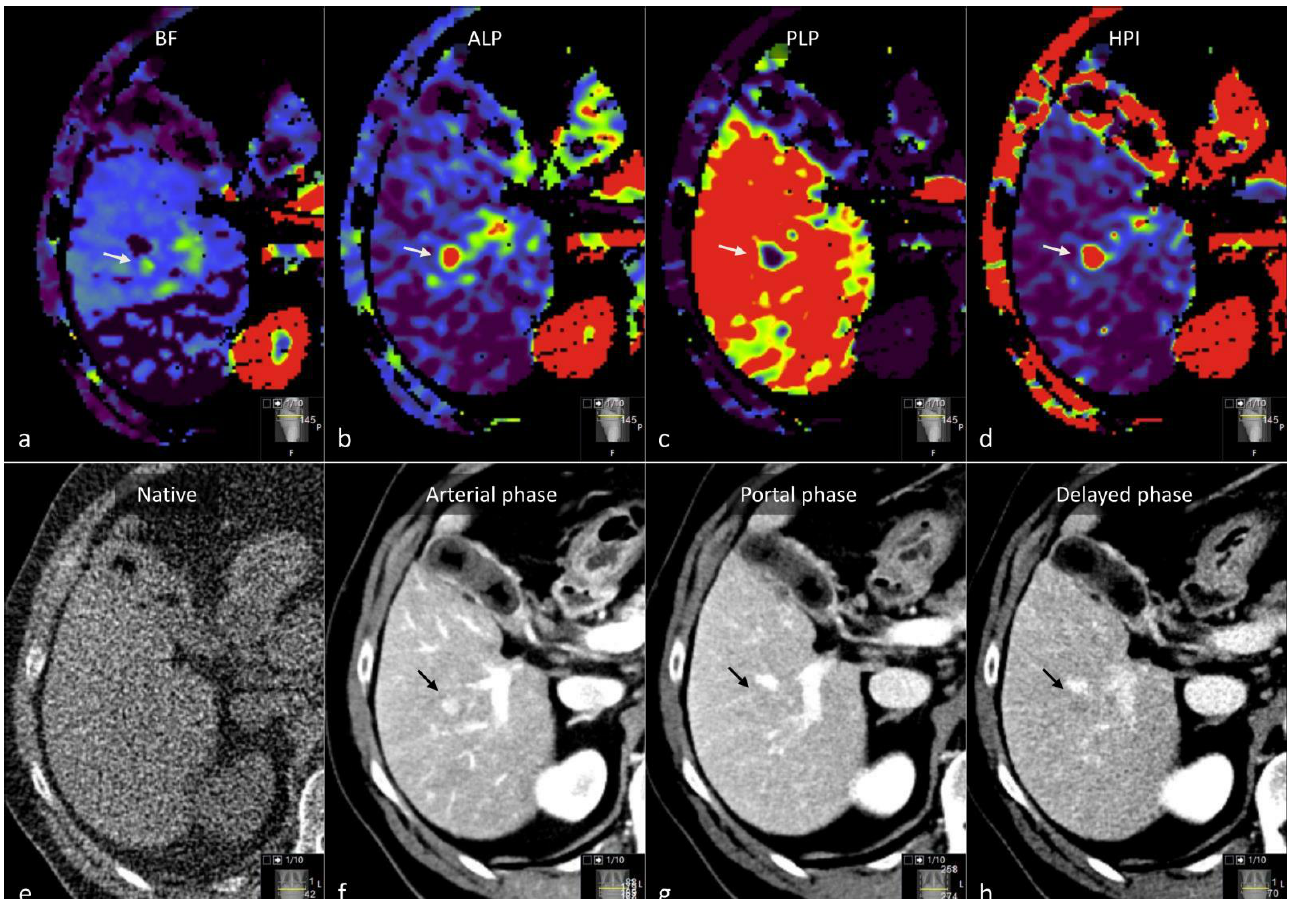
Figure 8. CT perfusion allows the accurate identification and characterization of HCC lesions. In this 69-year-old patient with cirrhosis, a 12-mm nodular lesion in the right liver lobe (arrow) can be easily distinguished from surrounding liver parenchyma on CT perfusion ( a – d ), with higher values on the Blood Flow ( a ), Arterial Liver Perfusion ( b ), and Hepatic Perfusion Index ( d ) parametric maps and a lower value on the Portal Venous Perfusion ( c ) map. The lesion is shown on conven- tional 4-phase CT ( e – h ), which was performed on the same day as CT perfusion with arterial phase hyperenhancement ( f ) and wash-out on the portal-venous ( g ) and delayed phase ( h ), which cor- responds to LI-RADS 5. BF; Blood Flow, ALP; Arterial Liver Perfusion, PLP; Portal Liver Perfusion, HPI; Hepatic Perfusion Index.